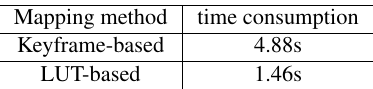
Table 2. Average time consumption